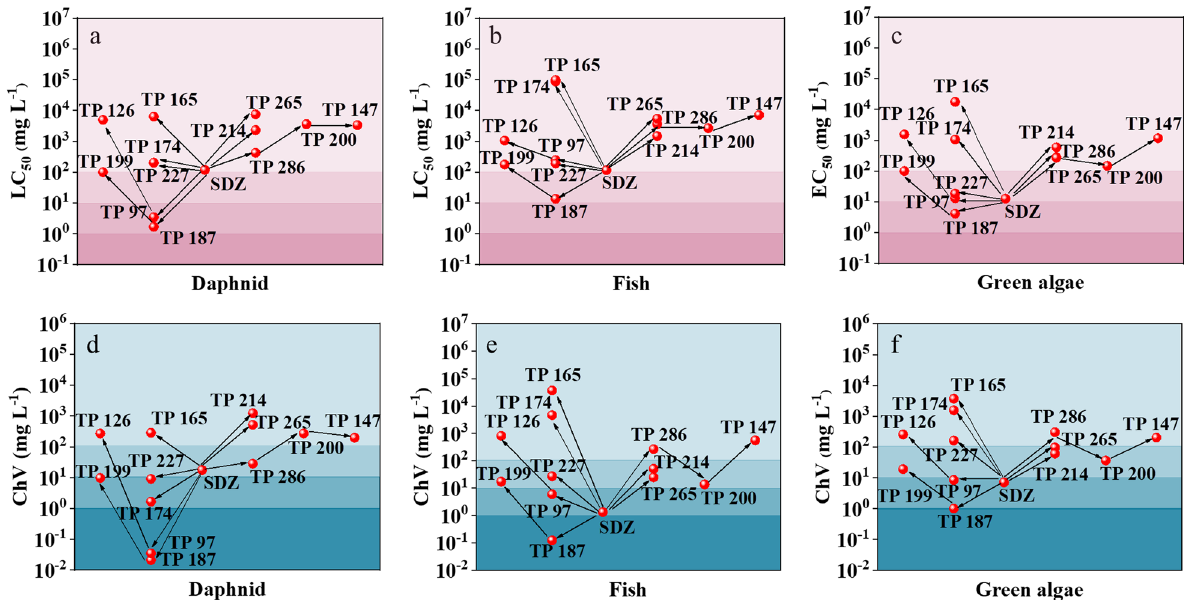
Fig. 7 Eco-toxicity estimates of SDZ and its TPs via ECOSAR in SK-C/PDS system. LC 50 represents the half-lethal concentration, and EC 50 represents the half-effective